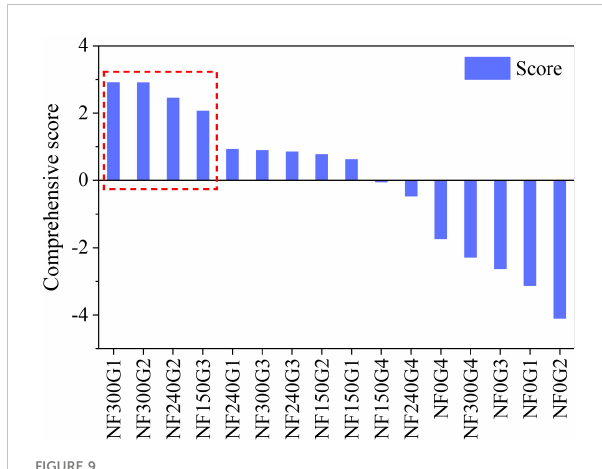
FIGURE 9 Scores and ranking of combined treatment of WTD with N